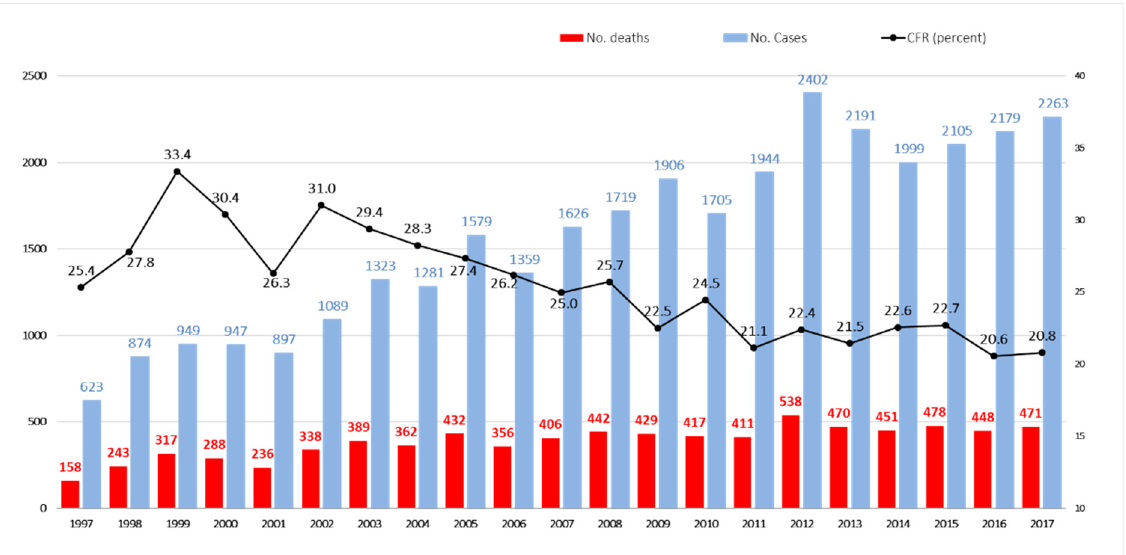
Figure 1. Temporal distribution of annual number of deaths, cases and CFRs (percent) in aspergillosis inpatients in Spain, 1997–2017. Table 1. Main comparative data of Aspergillus inpatients in Spain during 1997–2017: Deaths vs.